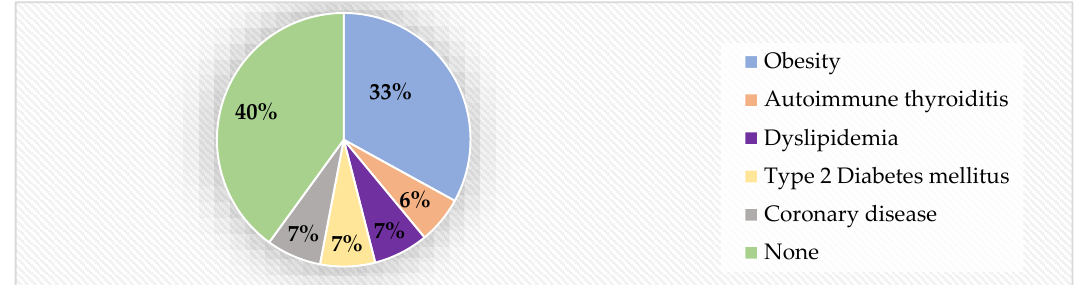
Figure 5. Family history of risk factors, in overweight children.